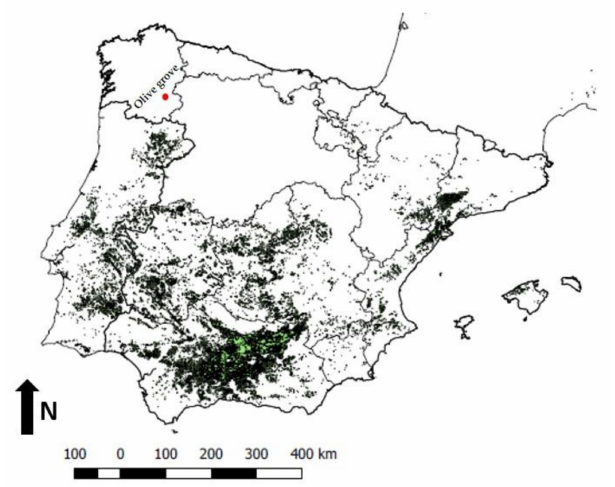
Figure 1. Location of olive groves in the Iberian